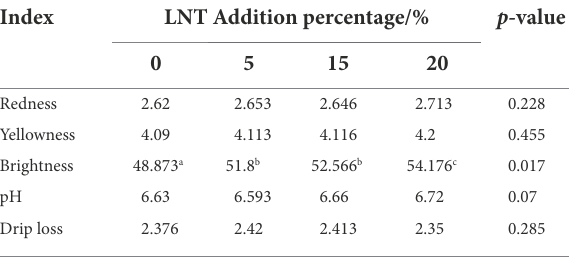
TABLE 3 Effect of LNT on meat quality of meat rabbits.